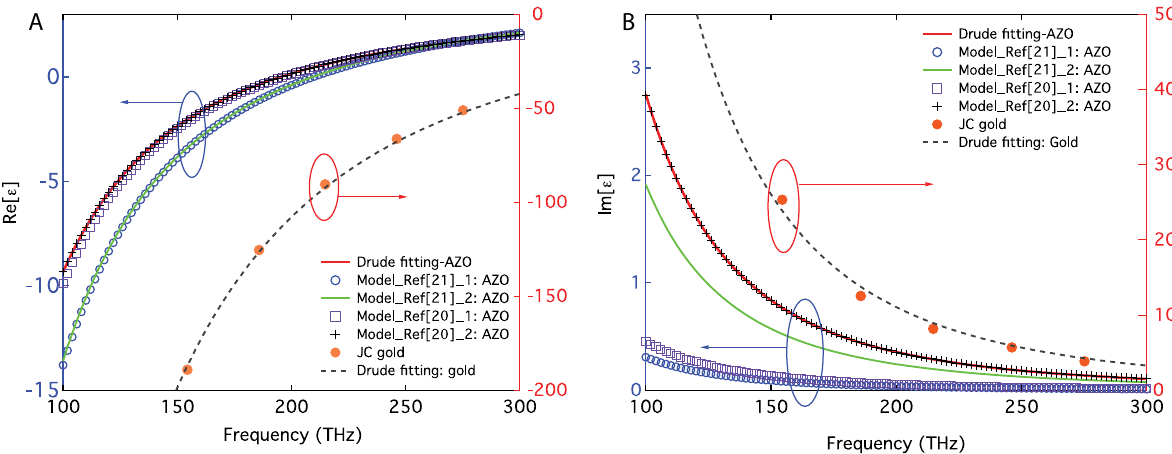
Figure 1 Comparison of data for gold and AZO between 100 and 300 THz: (A) Re(ε) and (B) Im(ε). For AZO, our fitted Drude model is listed together with the models in Refs. [21] and [24] w/ and w/o a 2 π factor taken into account in the corresponding collision frequency. For gold, our Drude fitted model is shown consistent with experimental data by Johnson and Christy